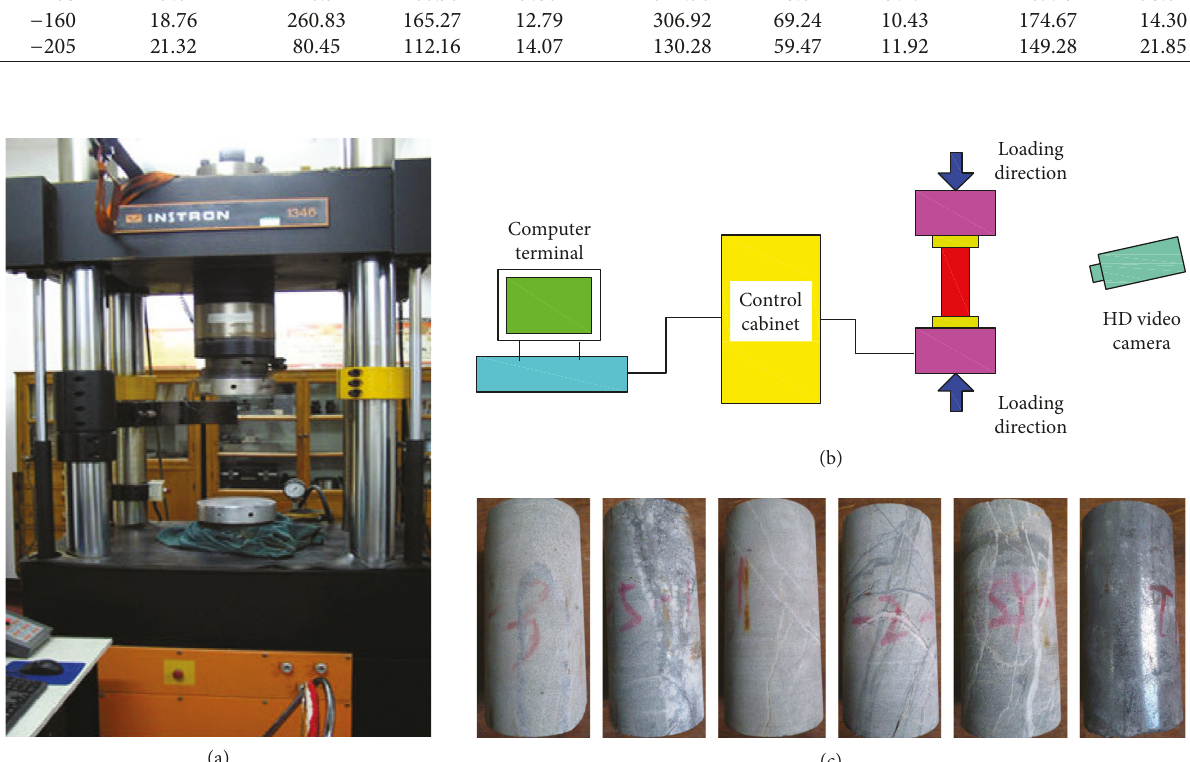
Figure 9: The experimental setup. (a) Universal hydraulic testing machine. (b) The experimental system. (c) Six kinds of rock